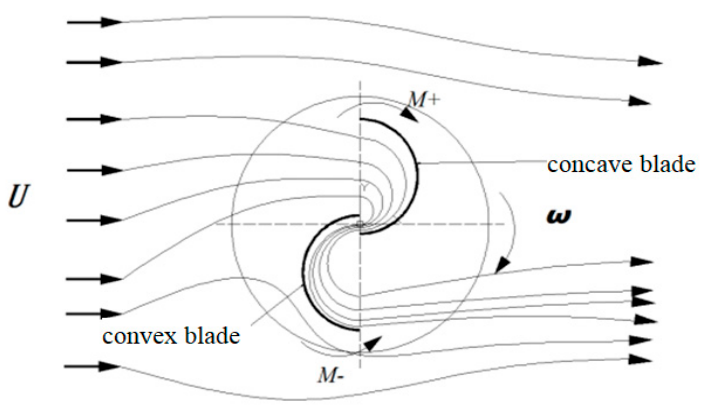
Figure 1. Working principle of the conventional Savonius wind rotor.